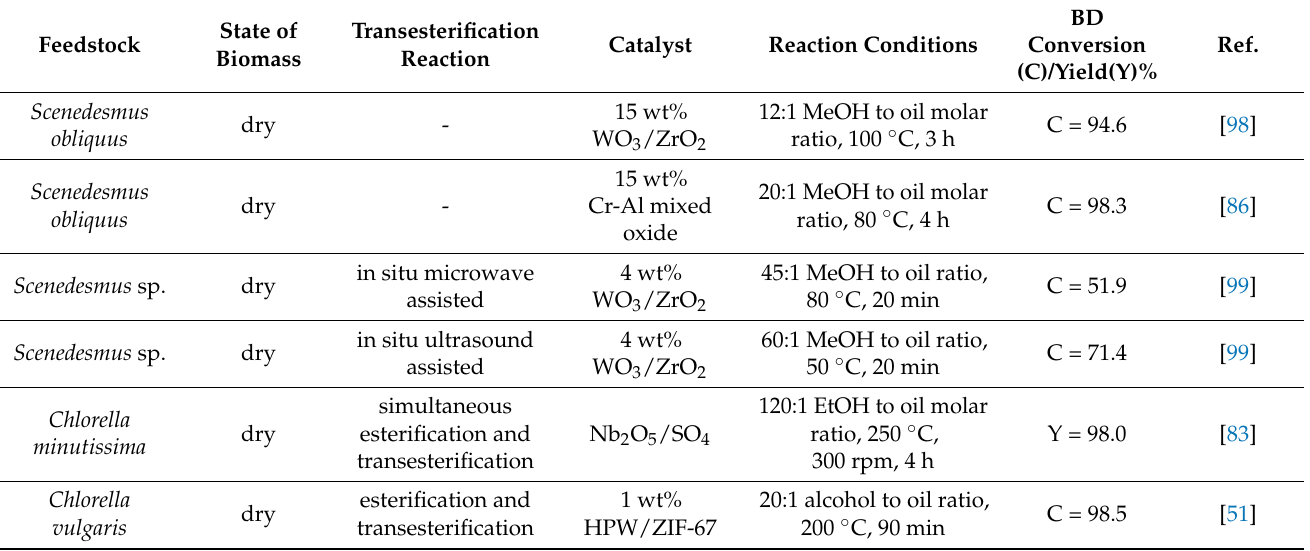
Table 5. Summary of heterogeneous acid catalysts studied for the transesterification of microalgae